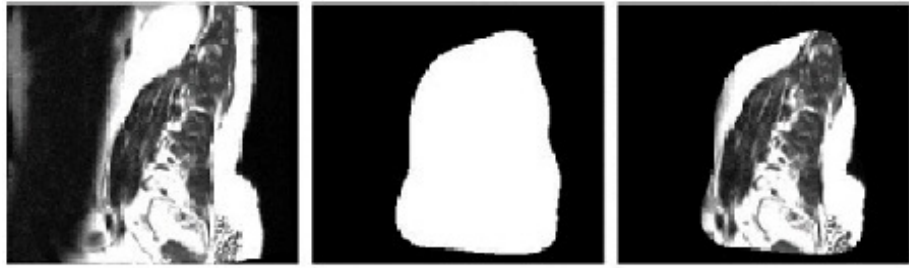
Figure 3. Input spinal cord image, its Saliency Mask, and final Saliency Map image. The extracted regions are processed via a Masked Region CNN model, which